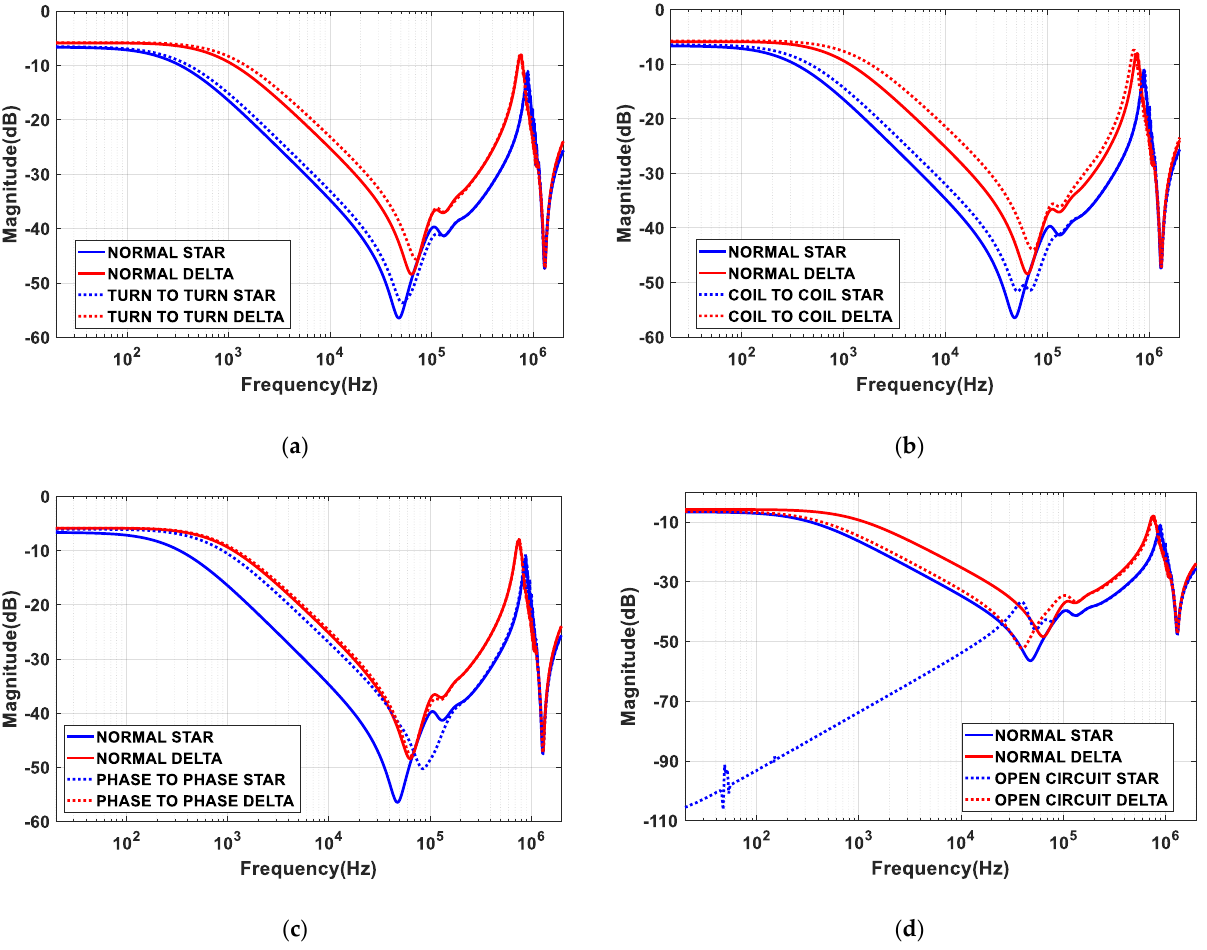
Figure 5. FRA measured responses for star vs. delta 5.5-IM at ( a ) Normal vs. Turn-to-Turn, ( b ) Normal vs. Coil-to-Coil, ( c ) Normal vs. Phase-to-Phase SC fault and ( d ) Normal vs. open circuit.